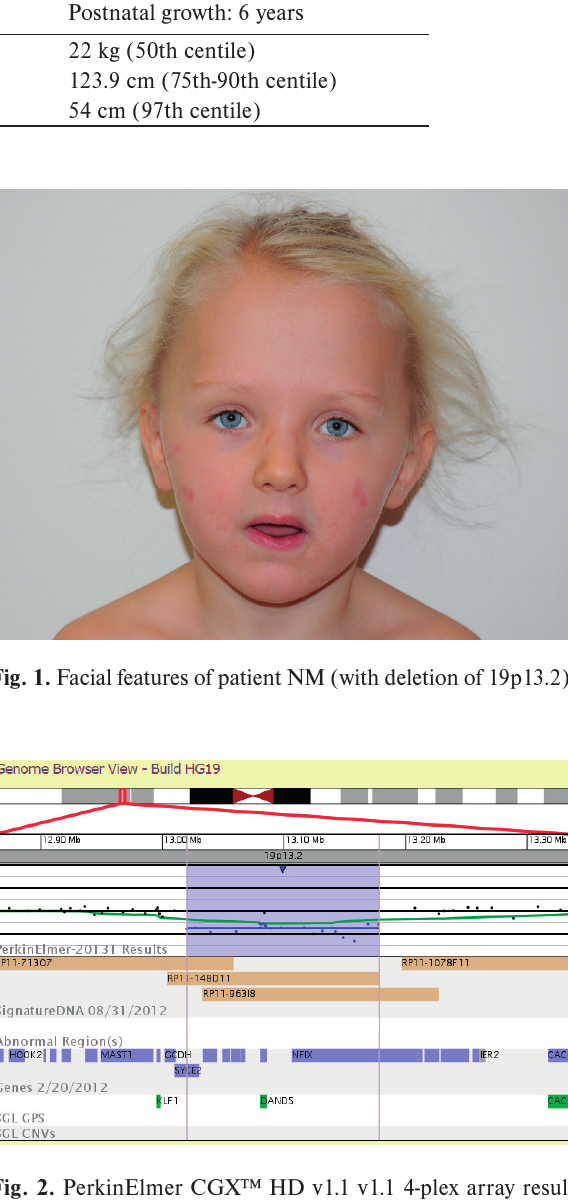
Table 1. Growth parameters of patient NM (with 19p13.2 deletion, including NFIX gene). Prenatal growth: 40 Hbd Postnatal growth: 6 years